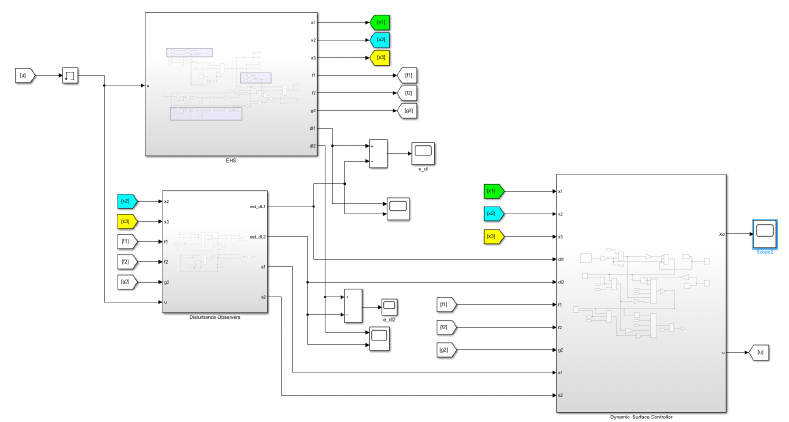
Figure A1. The calculation model of EHS from